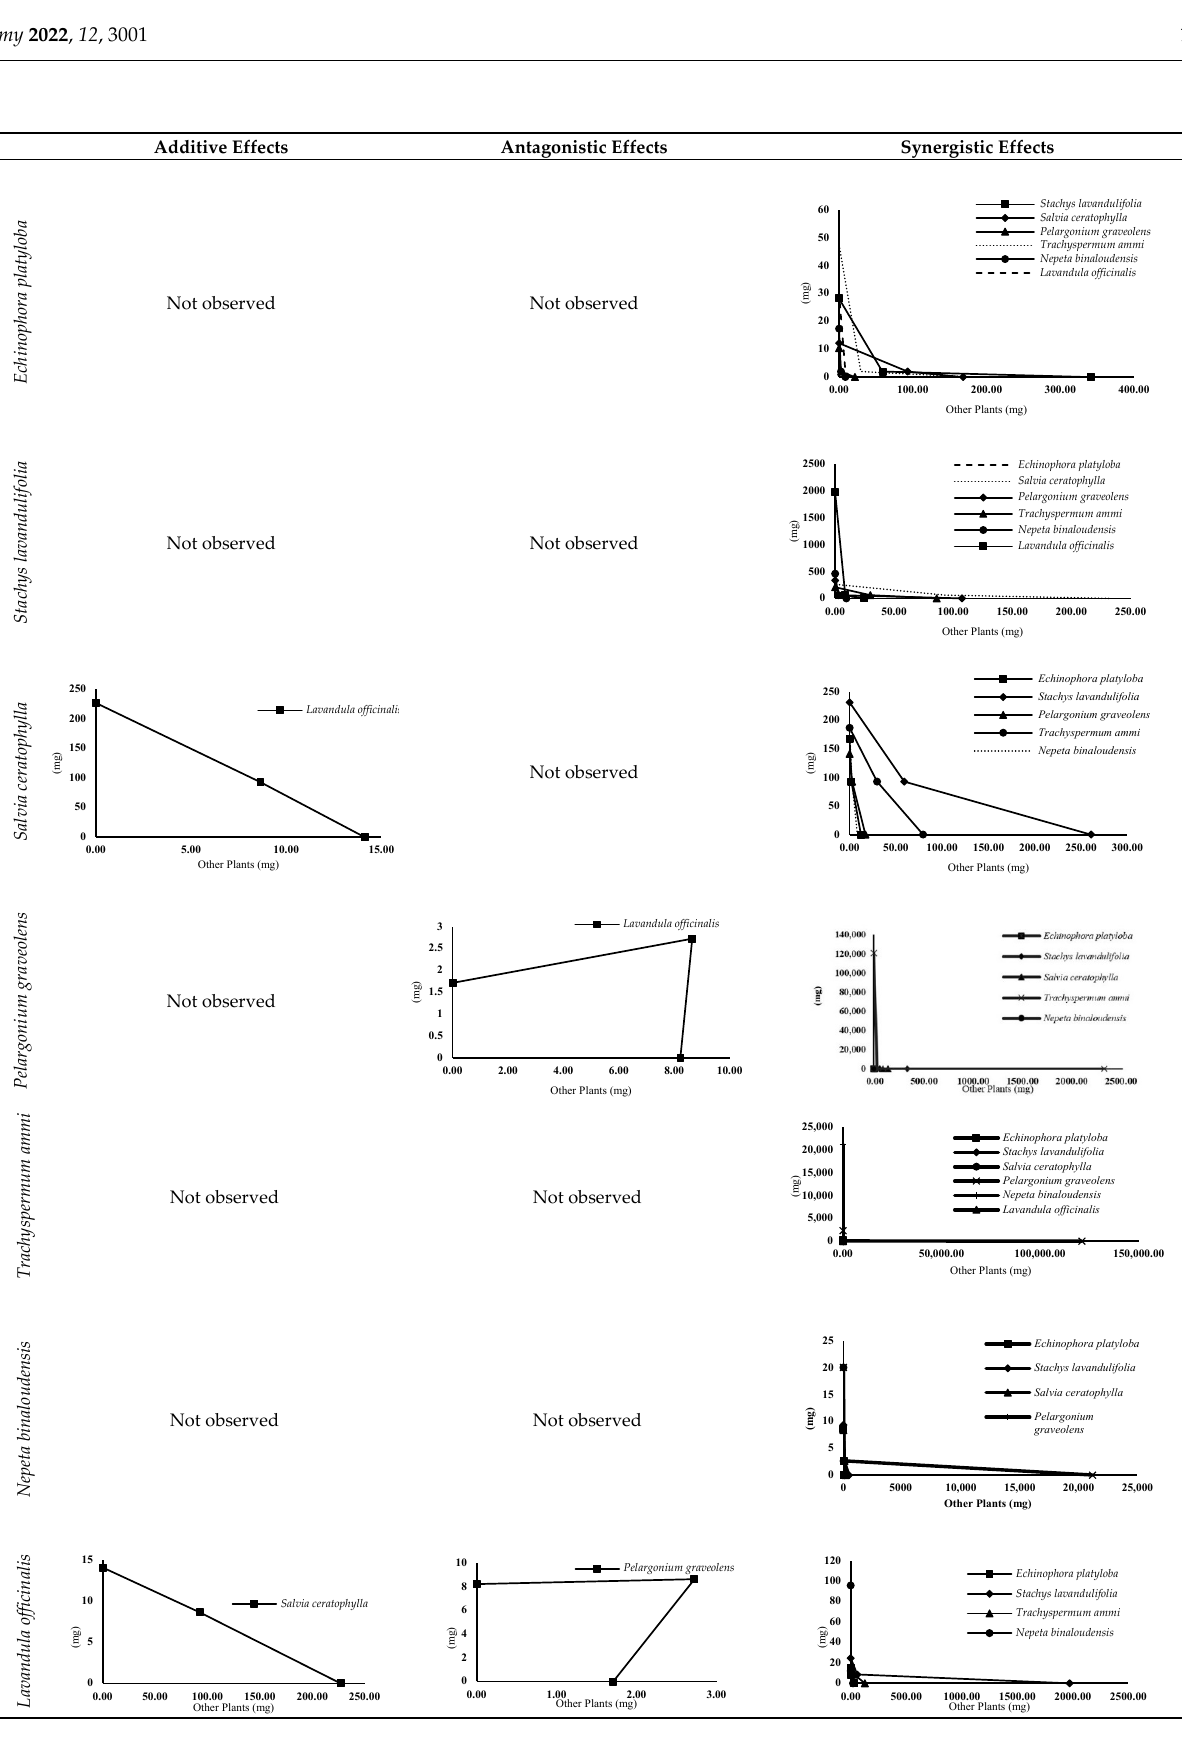
Figure 7. Isobologram curves of allelopathic interaction effects of plants on lettuce hypocotyl growth inhibition.